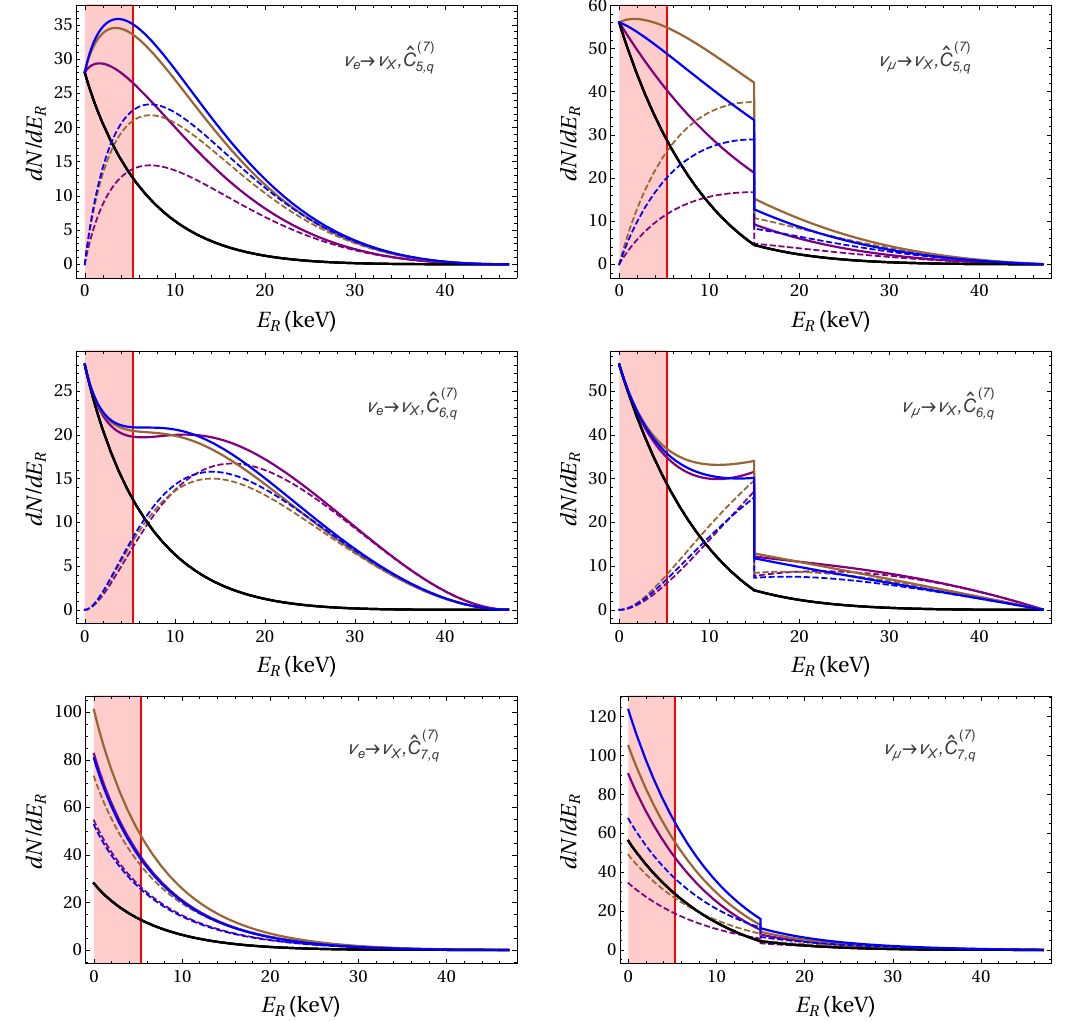
Figure 12 . The ν presence of NSI operators is as in figure